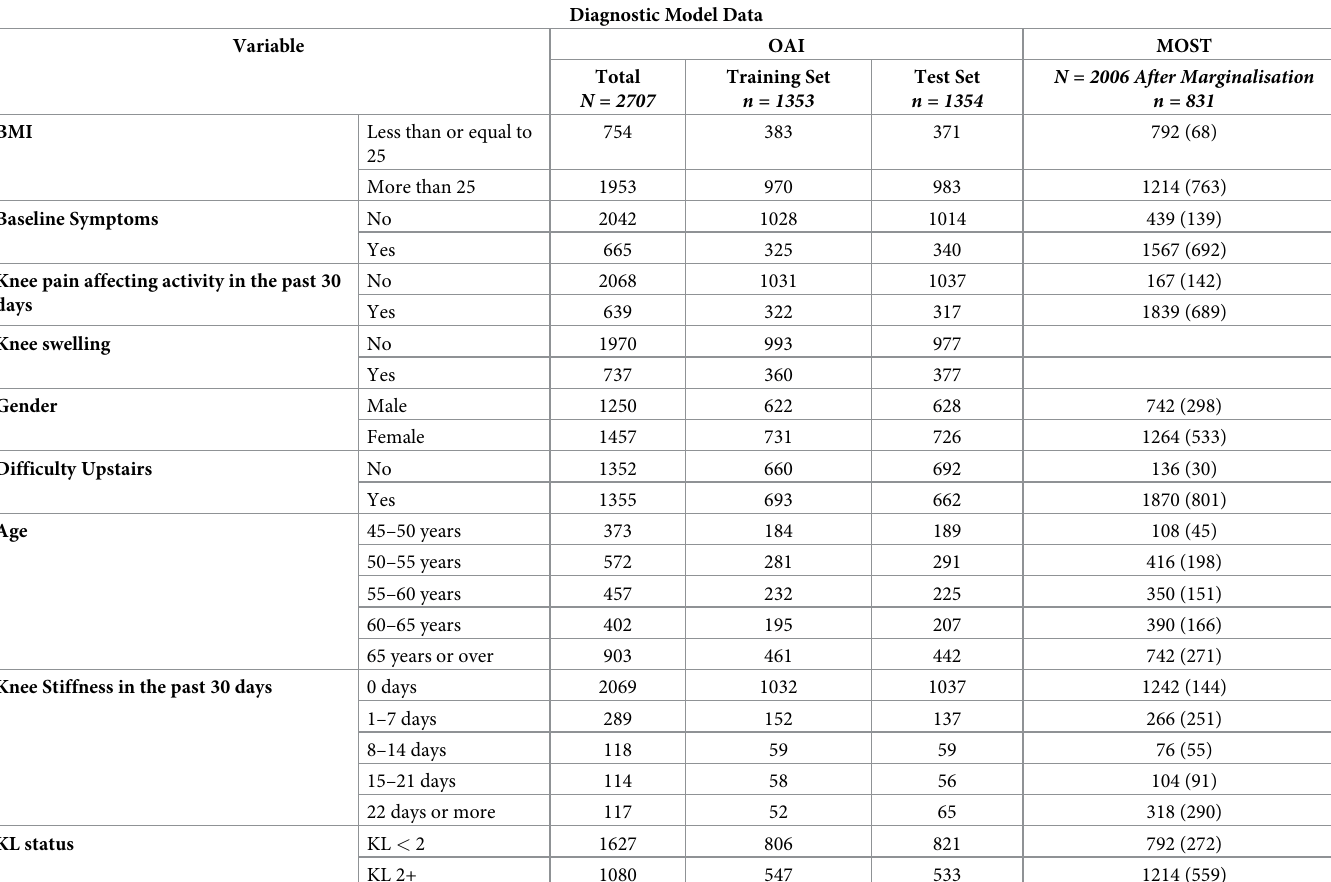
Table 1. Diagnostic model summary information of the Osteoarthritis Initiative (OAI) and Multicentre Osteoarthritis Study (MOST) datasets. Diagnostic Model